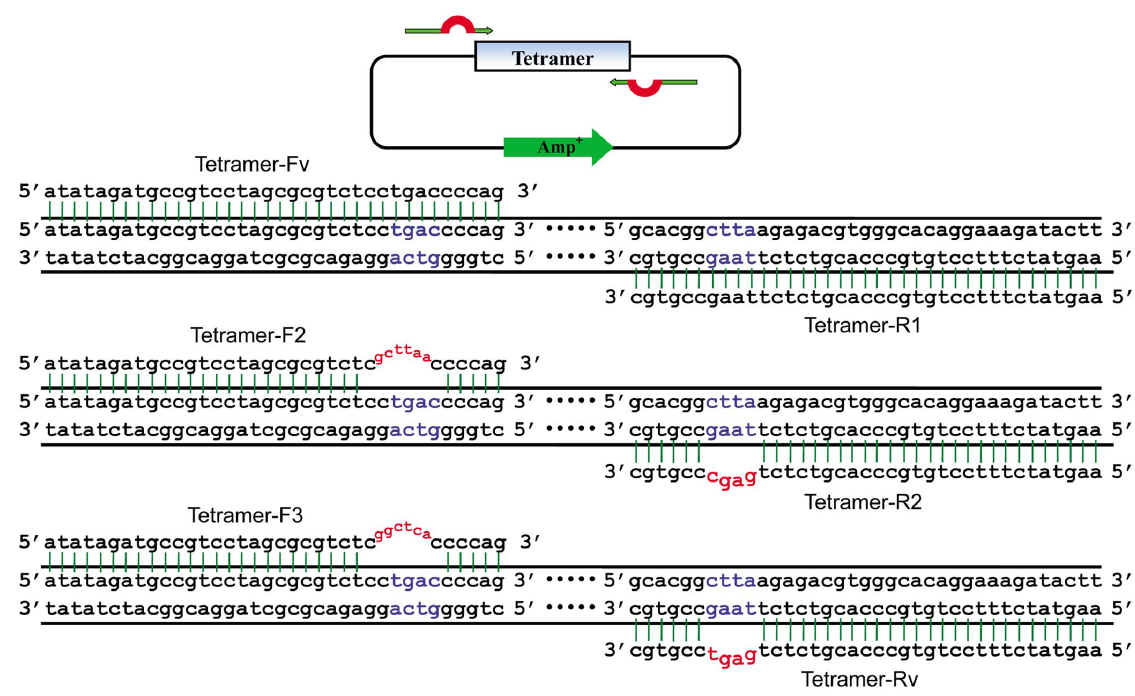
Figure 2. Schematic representation of tetramer PCR mutation. Cohesive ends of tetramers in the library can be changed after amplification with Tetramer-F1/Tetramer-R1, Tetramer-F2/Tetramer-R2 or Tetramer-F3/Tetramer-R3 for position specification. The original bases on tetramer plasmids are in blue and mismatches on primers are in red. doi:10.1371/journal.pone.0066459.g002 PLOS ONE |